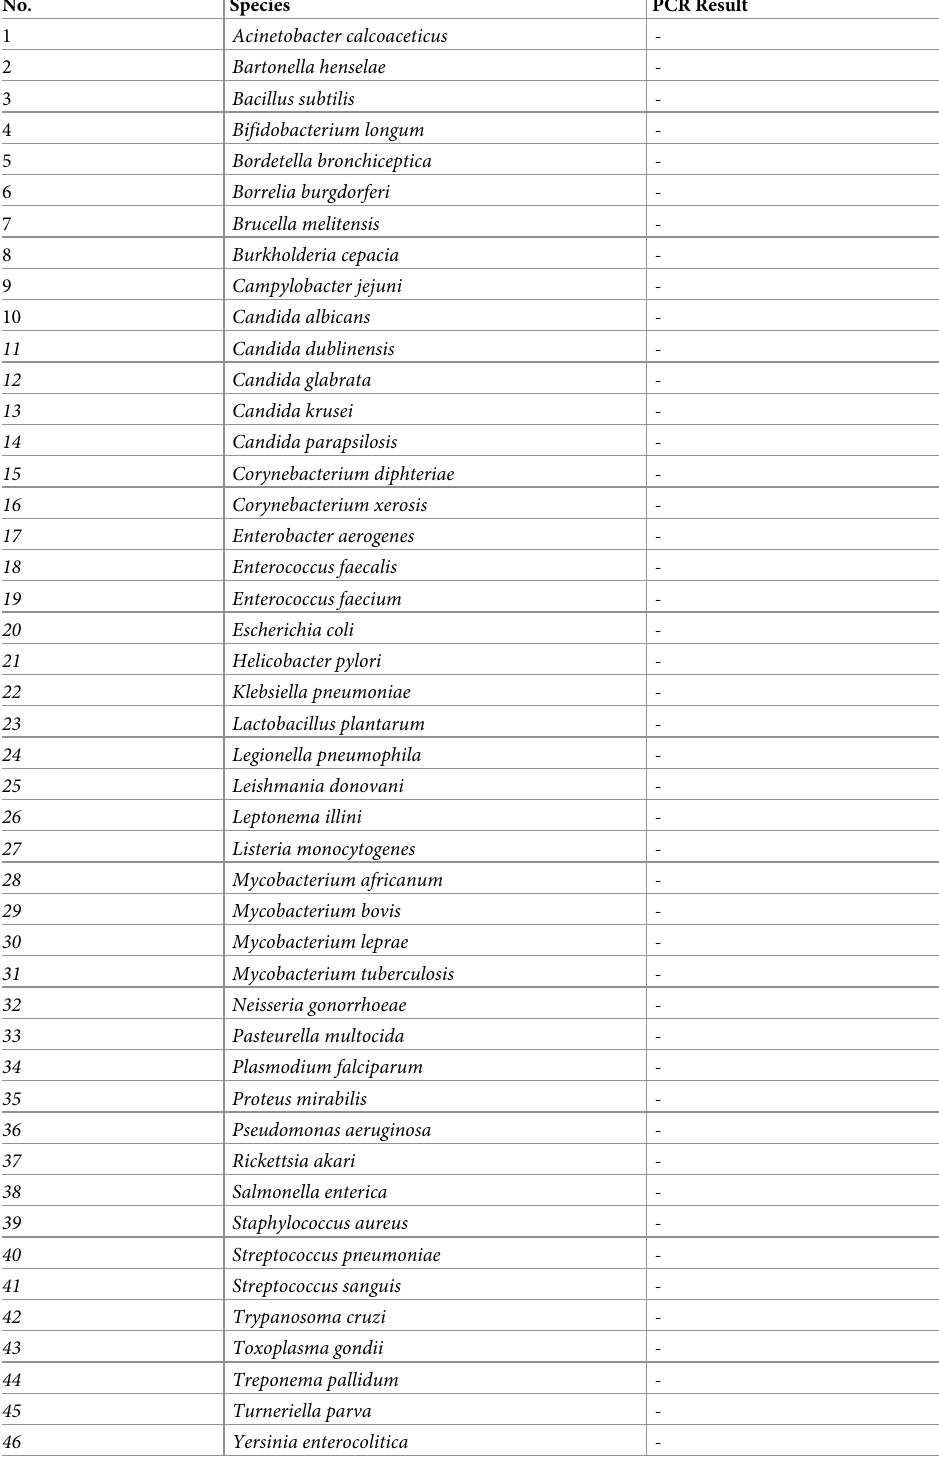
Table 2. Other micro-organisms tested in this